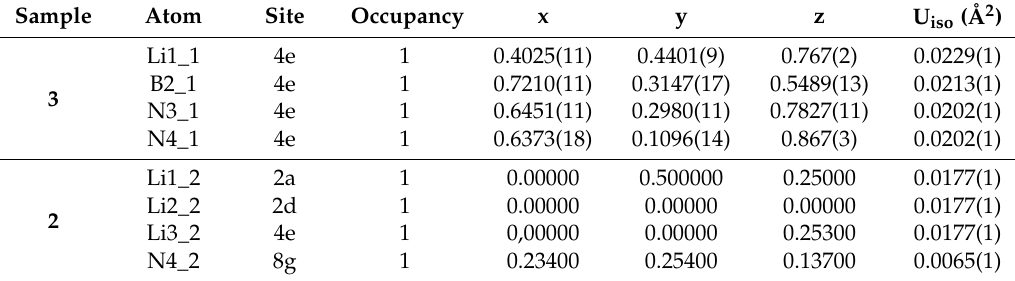
Table 2. Experimental structural parameters of 3 (LiN 2 H 3 BH 3 · x NH 3 ) and 2 (LiNH 2 ) at room temperature. The atomic positions for LiNH 2 were kept fixed during the refinement